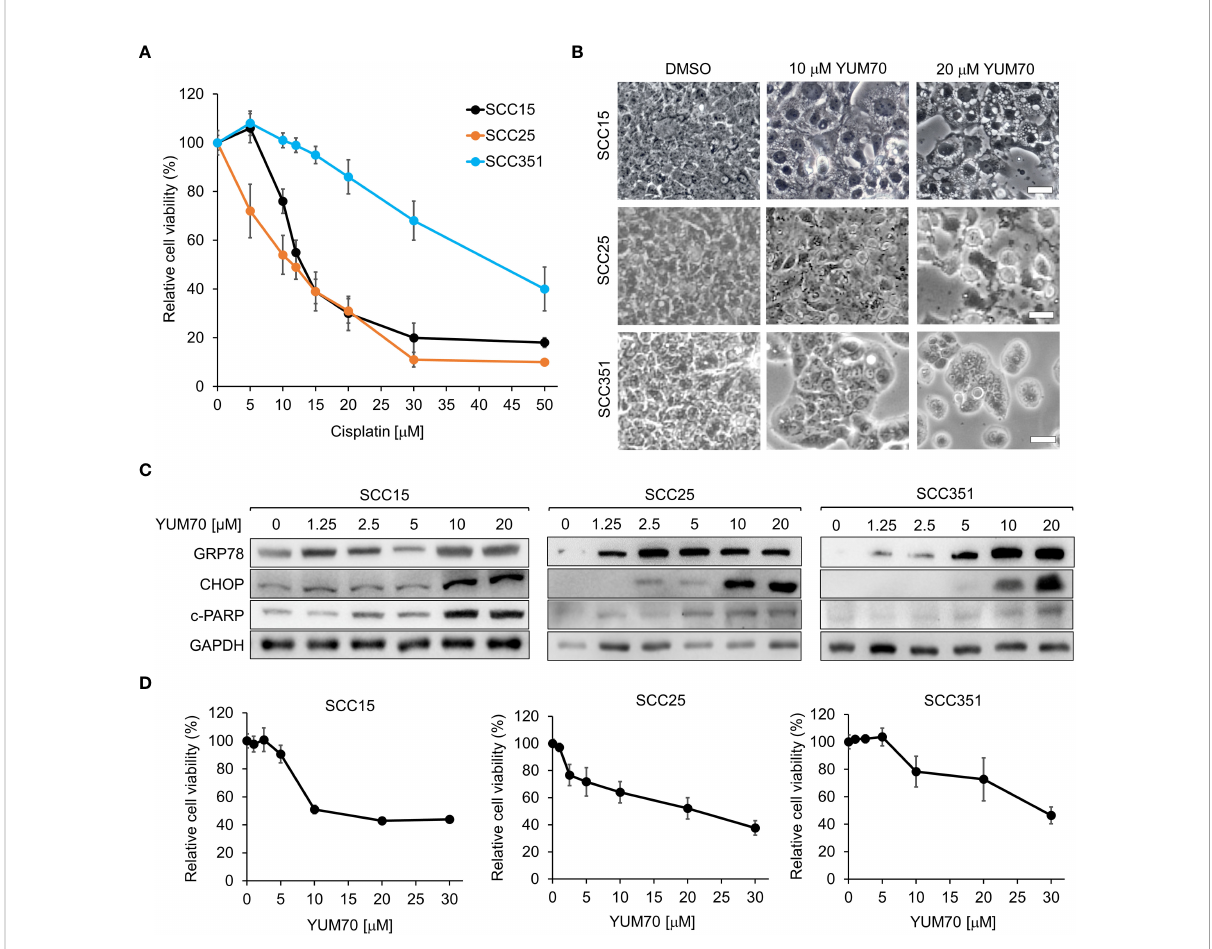
FIGURE 3 Treatment of GRP78 inhibitor YUM70 induces apoptosis and lowered cell viability of both cisplatin-sensitive and resistant HNSCC cell lines. (A) SCC15, SCC25, and SCC351 cells were treated with increasing doses of cisplatin, or PBS as a control, for 48 hr. Cell viability was determined by WST-1 assay. (B) Representative images of SCC15, SCC25, and SCC351 cells treated with the indicated concentrations of YUM70, or dimethyl sulfoxide (DMSO) as a control, for 48 hr. Scale bar = 50 m m. (C) Western blot analysis of lysates of SCC15, SCC25, and SCC351 cells treated with the indicated concentrations of YUM70 for 48 hr. The protein levels of GRP78, CHOP and cleaved-PARP (c-PARP) were determined, with GAPDH serving as loading control. (D) SCC15, SCC25, and SCC351 cells were treated with increasing doses of YUM70 or DMSO for 48 hr. Cell viability was determined by WST-1 assay. Data are presented as means ± S.D.